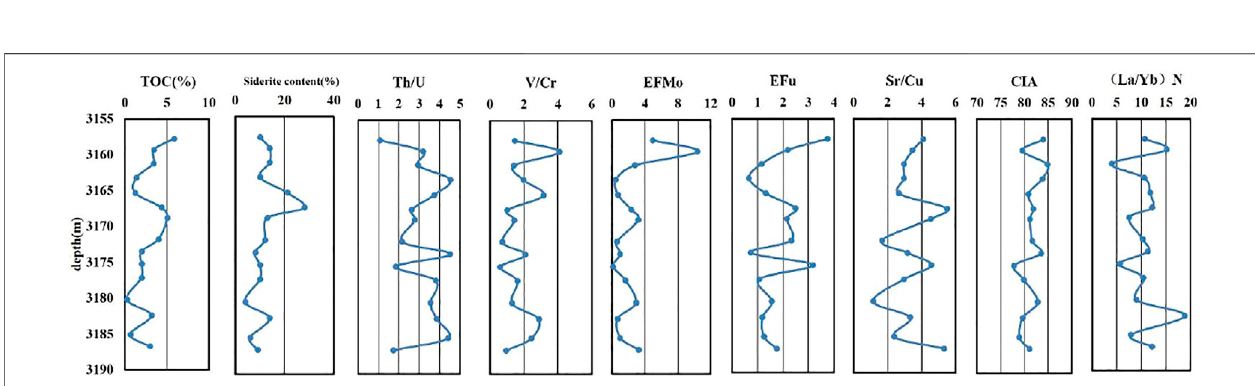
Frontiers in Earth Science |